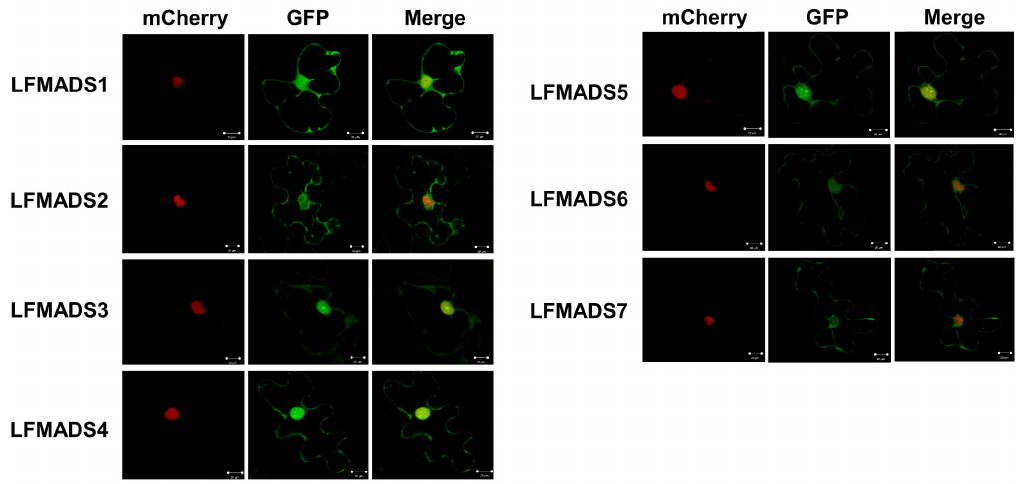
Figure 5. Subcellular localization of seven fluorescent LFMADS-mGFP proteins. Recombinant plasmids harboring a C-terminal mGFP fusion with LFMADSs were driven by the CaMV 35S promoter (35S::LFMADSs-mGFP). These seven recombinant proteins were transiently expressed in lily tepal by using the particle bombardment method. The NLS domain of VirD2 fused with mCherry in this study was used as the nuclear marker control. Overlay (merge) images are shown in the extreme right column. Bar = 20 μm.